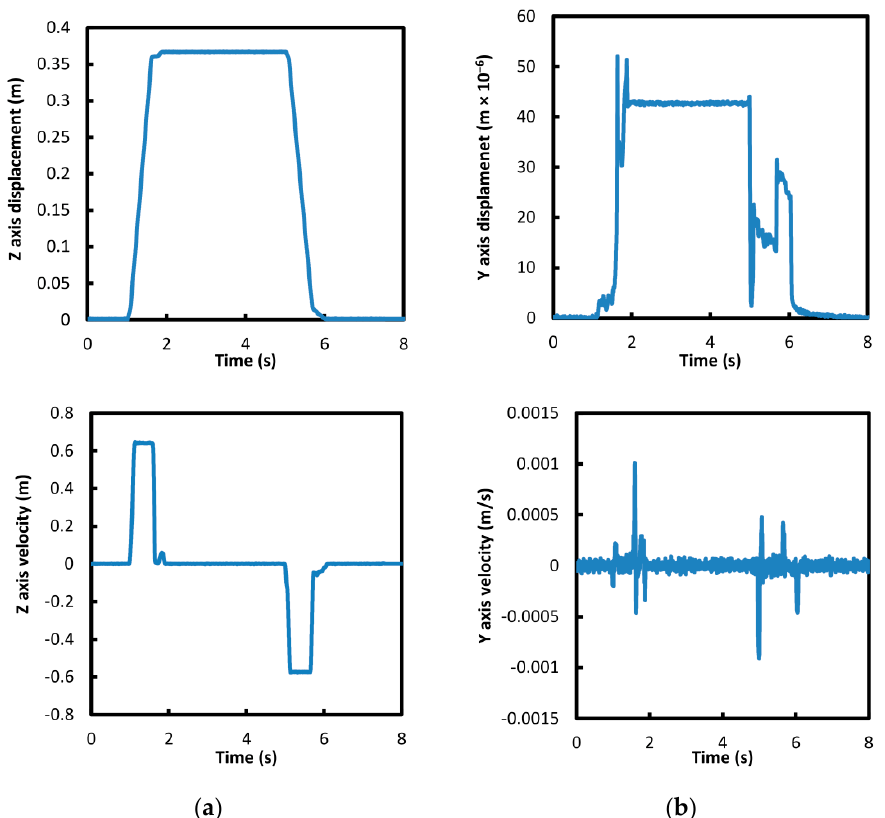
Figure 5. Displacement and velocity sources; ( a ) Z axis; ( b ) Y axis.